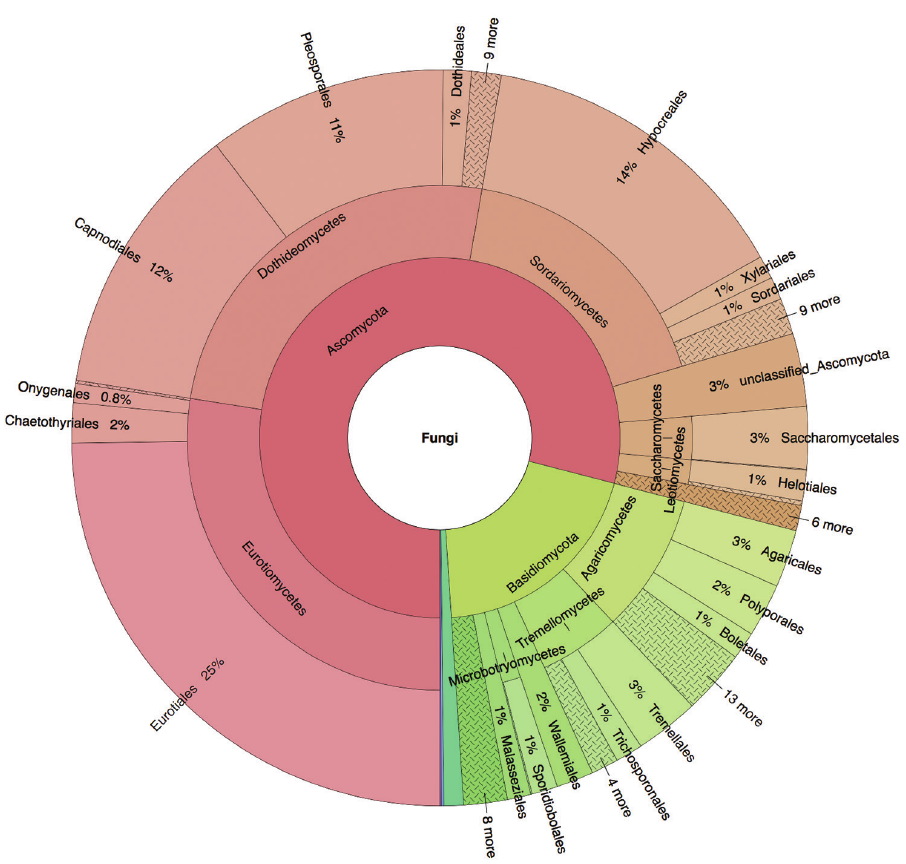
Figure 2. Krona chart of the taxonomic affiliation of the built environment sequences down to order level. The Krona chart lists all annotated built environment sequences except those classified as Fungi sp. (32%) and those of non-fungal origin (1%). An interactive version of the Krona chart is provided as Supplementary mate- rial 4. The figure is based on Abarenkov et al. (2016) plus the data added during the workshop, such that it in- dicates the scientific state of ITS-based Sanger-derived sequencing of the built mycobiome as of spring